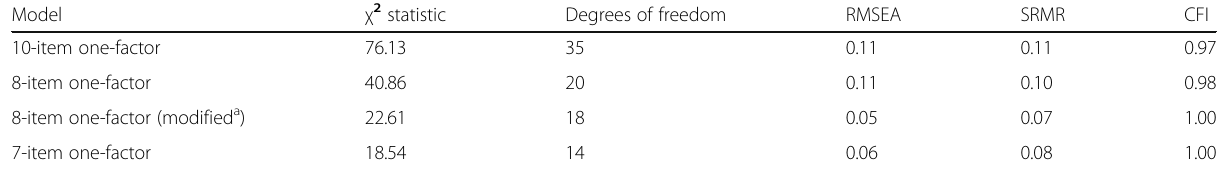
Table 2 Model fit indices in confirmatory factor analysis of the Chinese version of THAT Model χ 2 statistic